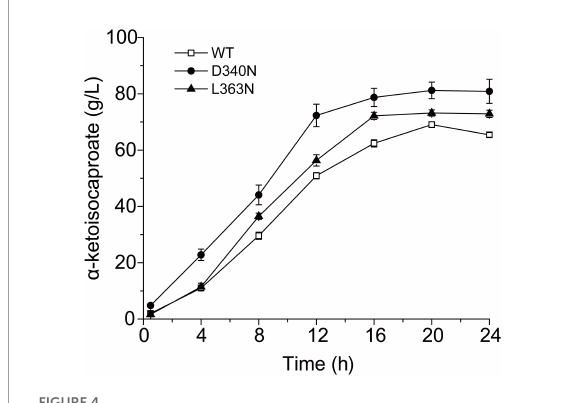
FIGURE4 The time profiles of α -ketoisocaproate synthesis by the wild-type (WT) L -amino acid deaminase ( L -AAD) and mutants with L -leucine as